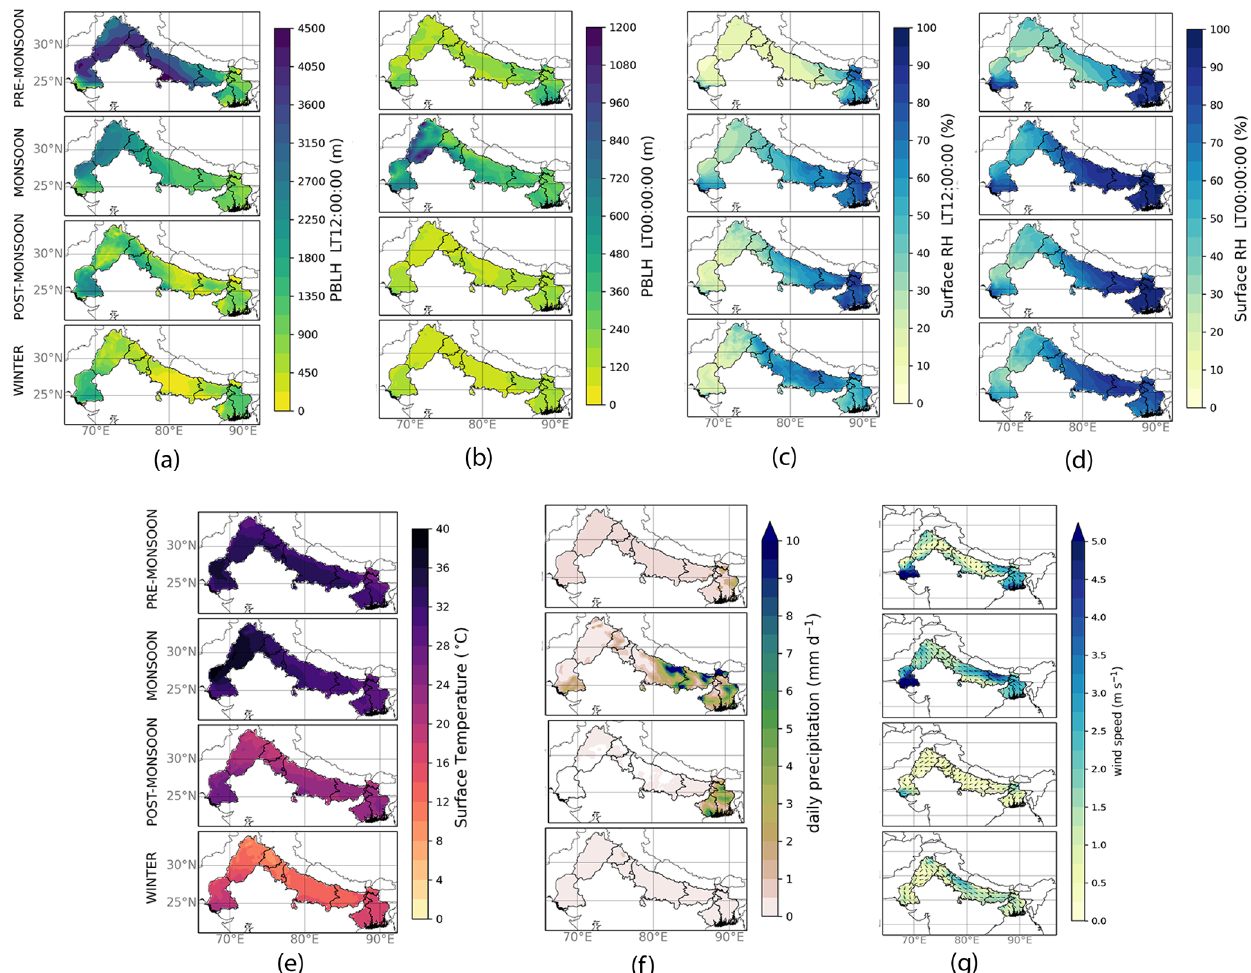
Figure A1. Seasonal mean WRF-Chem meteorological fields: (a) daytime planetary boundary layer height (m); (b) night-time planetary boundary layer height (m); (c) daytime surface relative humidity (%); (d) night-time surface relative humidity (%); (e) surface temperature at 2m ( ◦ C; f daily precipitation rate, mmd − 1 ); and (g) wind speed (ms − 1 ) and direction at